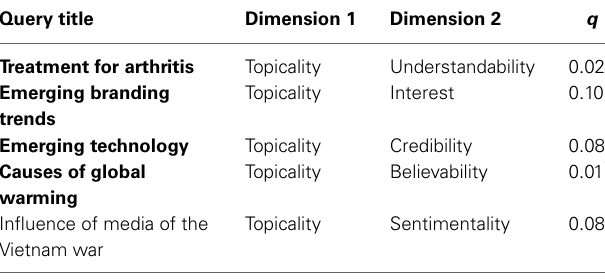
Table 3 | Summary table of q − test